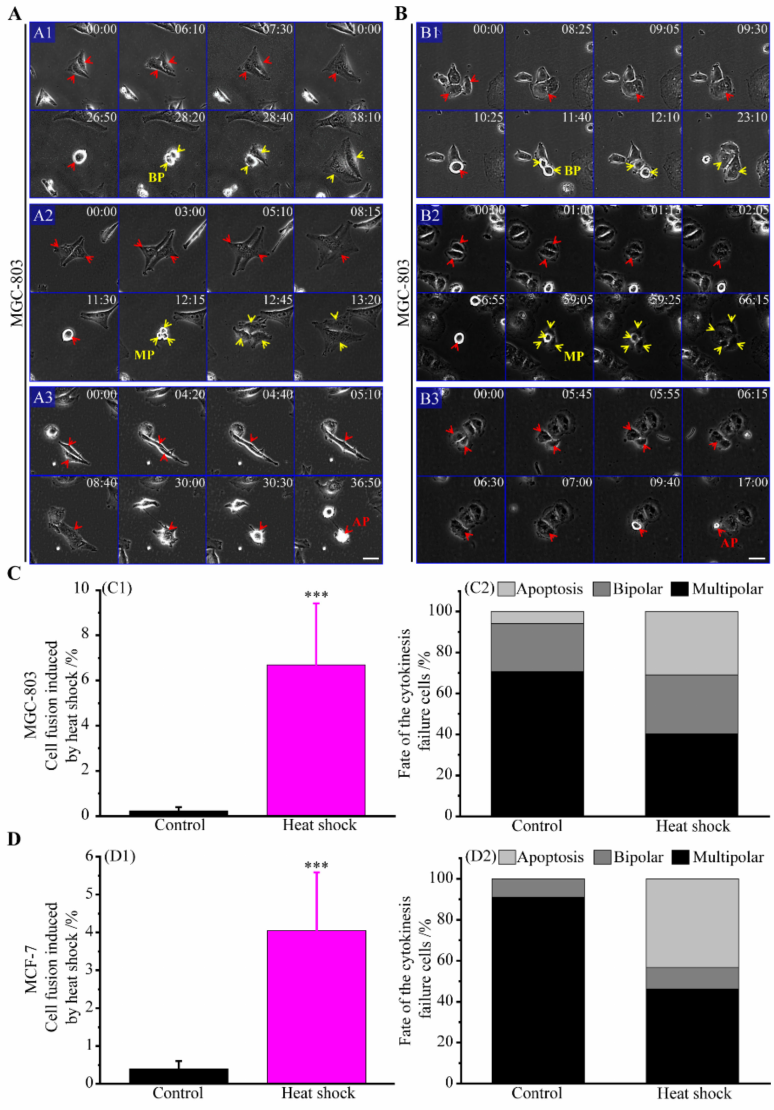
Figure 4. Cell fusion of cancer cells caused by heat stress and their fates. ( A ) Time-lapse images of MGC-803 cells; ( A1 ) bipolar division, ( A2 ) multipolar division, and ( A3 ) cell apoptosis of MGC-803 cells after cell fusion induced by heat stress, scale bar: 50 µ m. ( B ) Time-lapse images of MCF-7; ( B1 ) bipolar division, ( B2 ) multipolar division, and ( B3 ) cell apoptosis of MCF-7 cells after cell fusion induced by heat stress, scale bar: 40 µ m. ( C ) The cell fusion frequency of MGC-803 cells and their cell fates; ( C1 ) the frequency of MGC-803 cells with cell fusion (mean values ± SD are shown from three independent experiments); ( C2 ) MGC-803 cells fates with cell fusion; the ratios through the routes of bipolar divisions, multipolar divisions and cell apoptosis are 4:12:1 in the control group and 25:34:27 in the heat shock group of MGC-803 cells, respectively. ( D ) The cell fusion frequency of MCF-7 cells and their cell fates; ( D1 ) the frequency of MCF-7 cells with cell fusion (mean values ± SD are shown from three independent experiments); ( D2 ) MCF-7 cells fates with cell fusion; the ratios through the routes of bipolar divisions, multipolar divisions and cell apoptosis are 1:10:0 in the control and 7:31:29 in the heat shock group of MCF-7 cells, respectively. BP (bipolar), MP (multipolar), and AP (apoptosis). p -value < 0.05 was considered statistically significant, *** p <